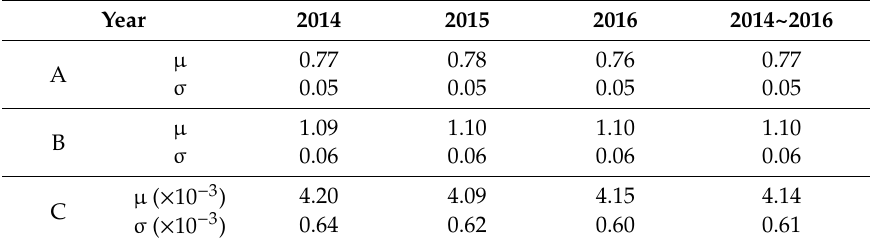
Table 3. The means and standard deviations of the Gompertz coe ffi cients by